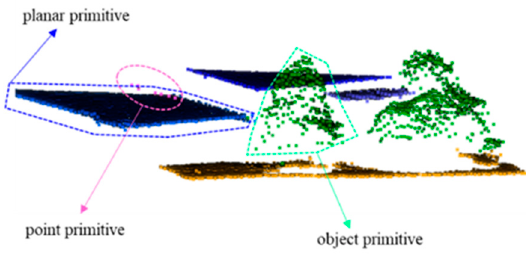
Figure 2. Multiple primitives to represent a scanning scene.